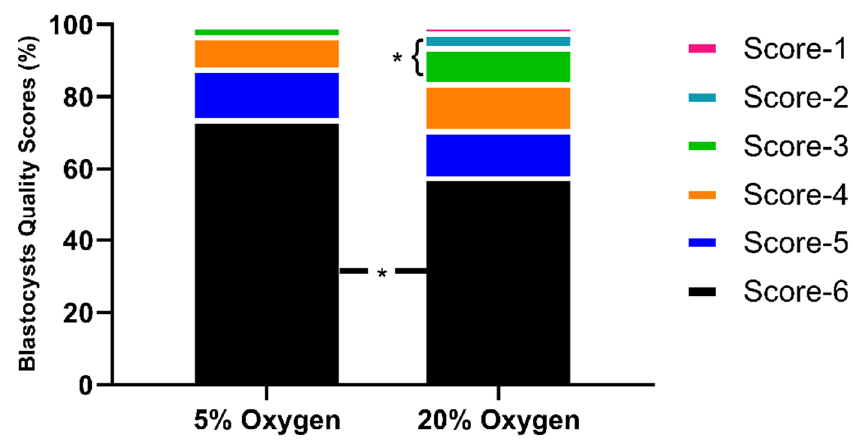
Figure 4. Embryo quality scoring. Physiological oxygen improved the quality of blastocysts, as indicated by lower percentage of low score blastocysts and higher proportionate of high score blastocysts. Asterisk (*) indicates the significant difference ( p < 0.05) between the groups.